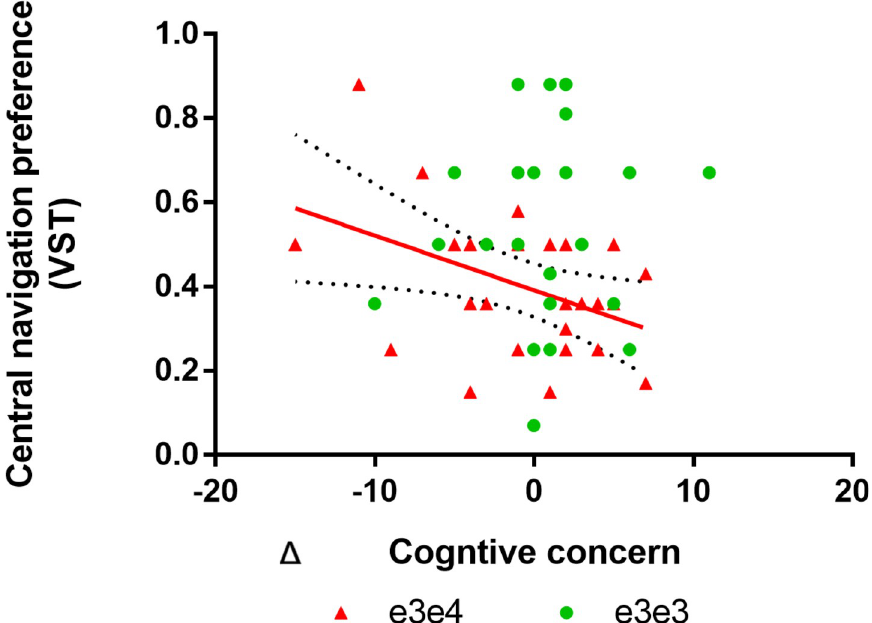
Fig 3. Navigation at baseline predicts worsening subjective concerns. Red line represents a significant association between baseline VST central navigation performance and change on CCI-episodic memory concern in ε 3 ε 4 carriers. Specifically, low baseline central navigation preference (a proxy for boundary-based place memory) predicts increased memory concern increase over 18 months in ε 3 ε 4 carriers. The same association was non-significant in ε 3 ε 3